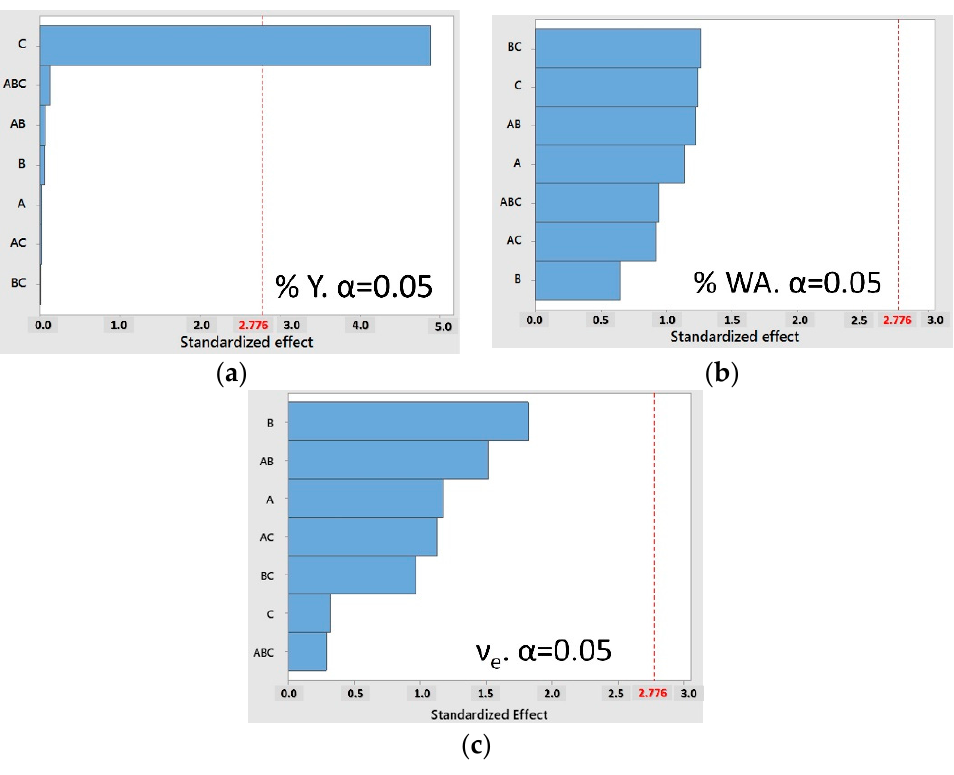
Figure 2. Result of the standardized Pareto analysis for the response variables (parameters A: MBA mol%; B: APS mol%; and C: CNF w w − 1 %): ( a ) yield of the reaction, ( b ) water absorption capacity, and ( c ) the effective cross-link density of the cross-linked